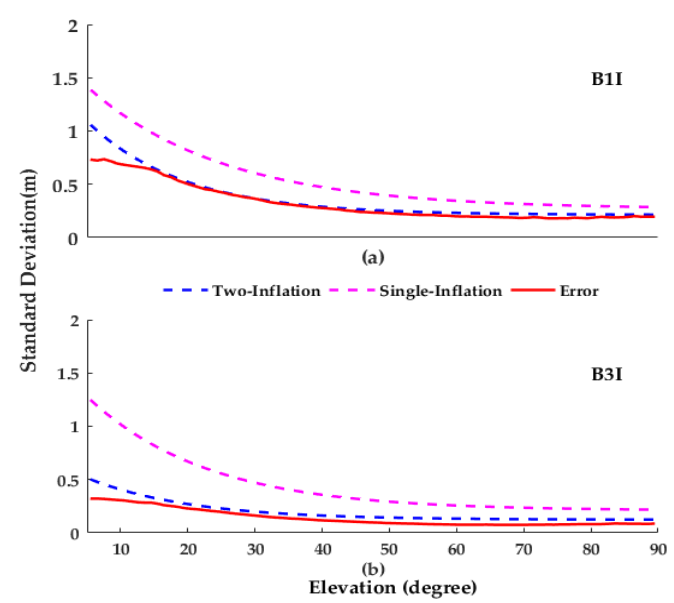
Figure 6. The modeled and the actual standard deviations of multipath error. The sub-figure ( a , b ) are results of B1I and B3I respectively.